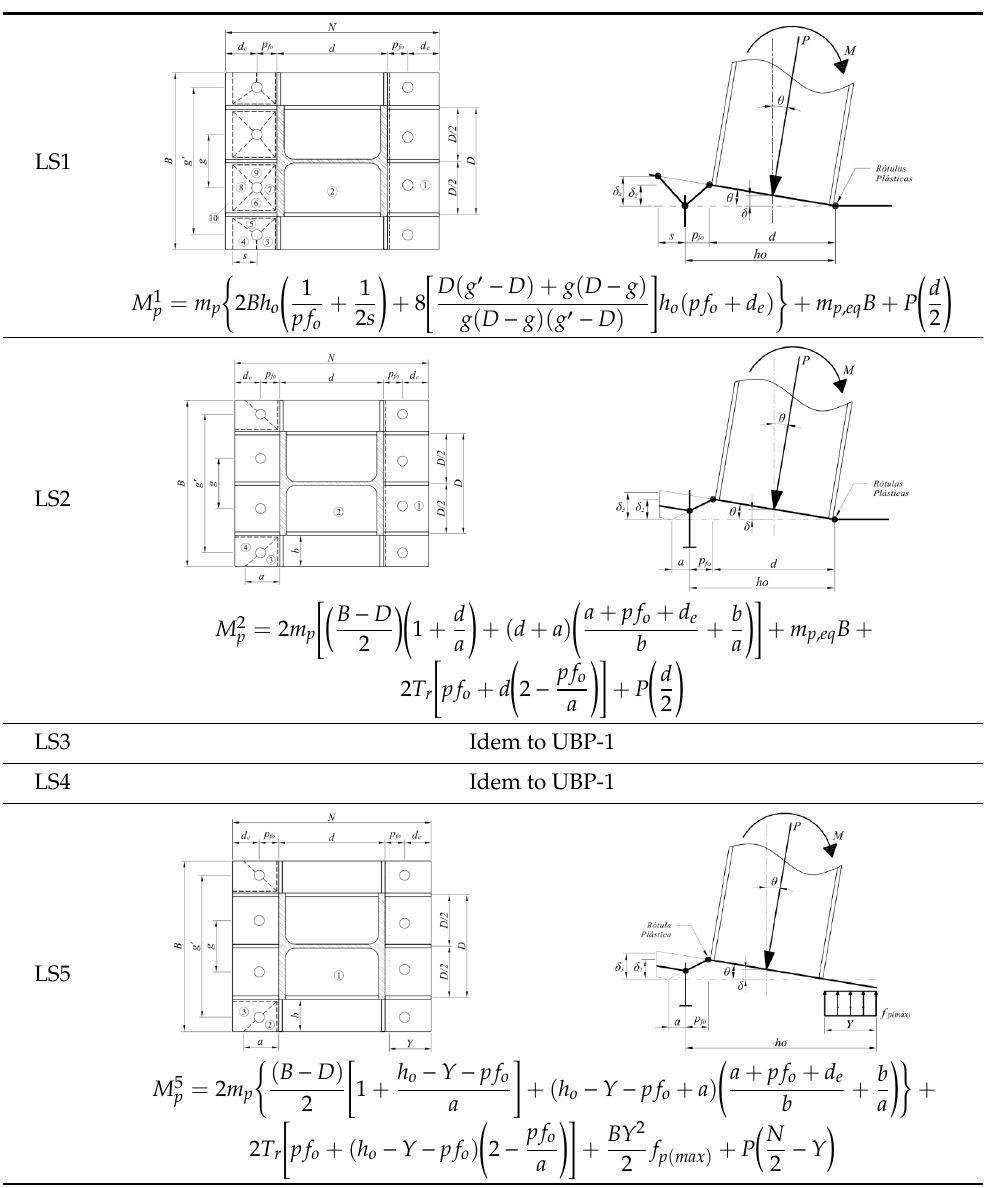
Table 4. Limit states that control the design of base plate type SBP-1.